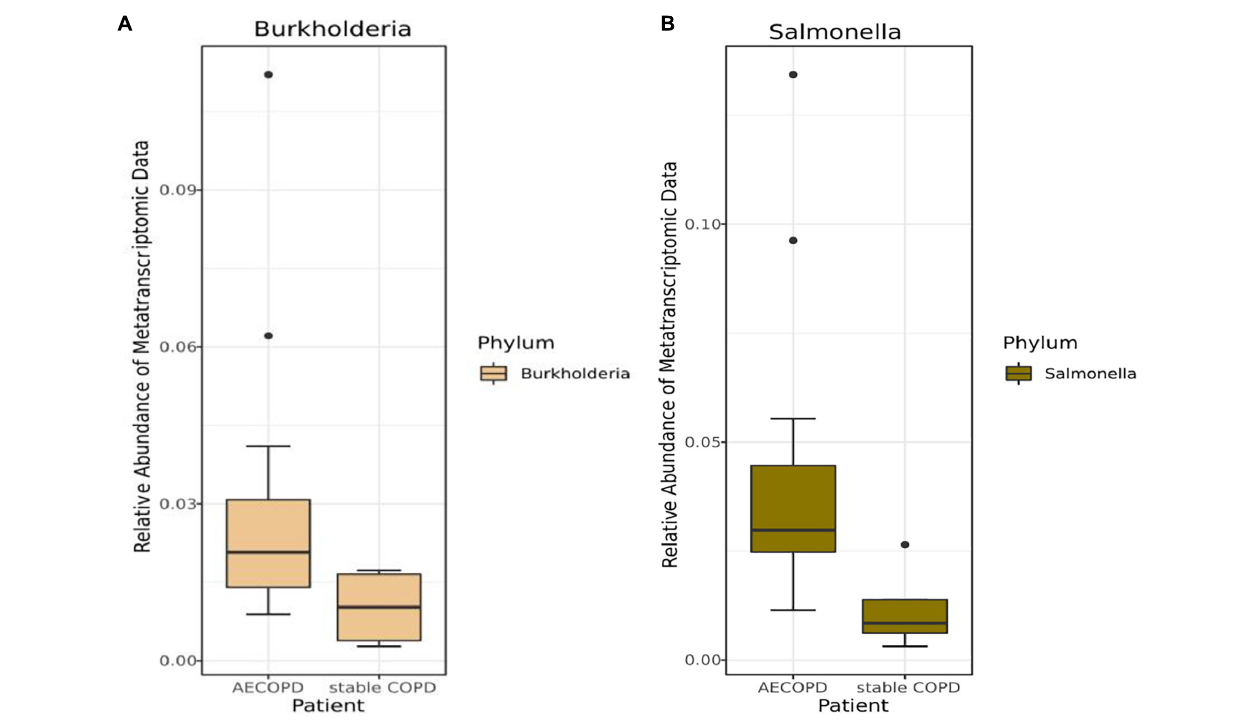
FIGURE 3 | Differences in the abundance of bacteria at the genus levels in the metatranscriptomic data with AECOPD and stable COPD patients. The box and whisker plots show the relative abundance of Burkholderia (A) and Salmonella (B) in the AECOPD and vs. stable